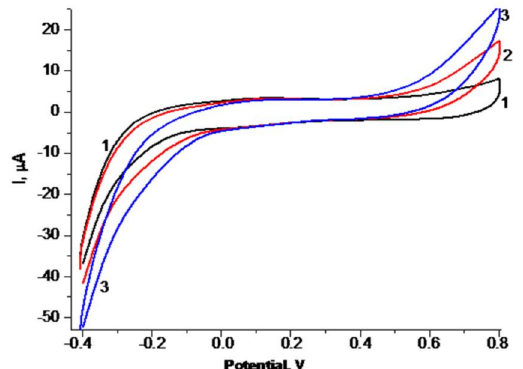
Figure 5. Cyclic voltammograms (CV) of the gCuHCF/GE. CV profiles (1–3) as outputs upon addition of H 2 O 2 up to concentrations: (1)—0 mM (black); (2)—0.17 mM (red); (3)—0.5 mM (blue) mM. Conditions: scan rate 50 mV · s − 1 ; Ag/AgCl (reference electrode) in 50 mM PB, pH 6.0. The sensing layer contains 0.35 mU of PO-like activity.